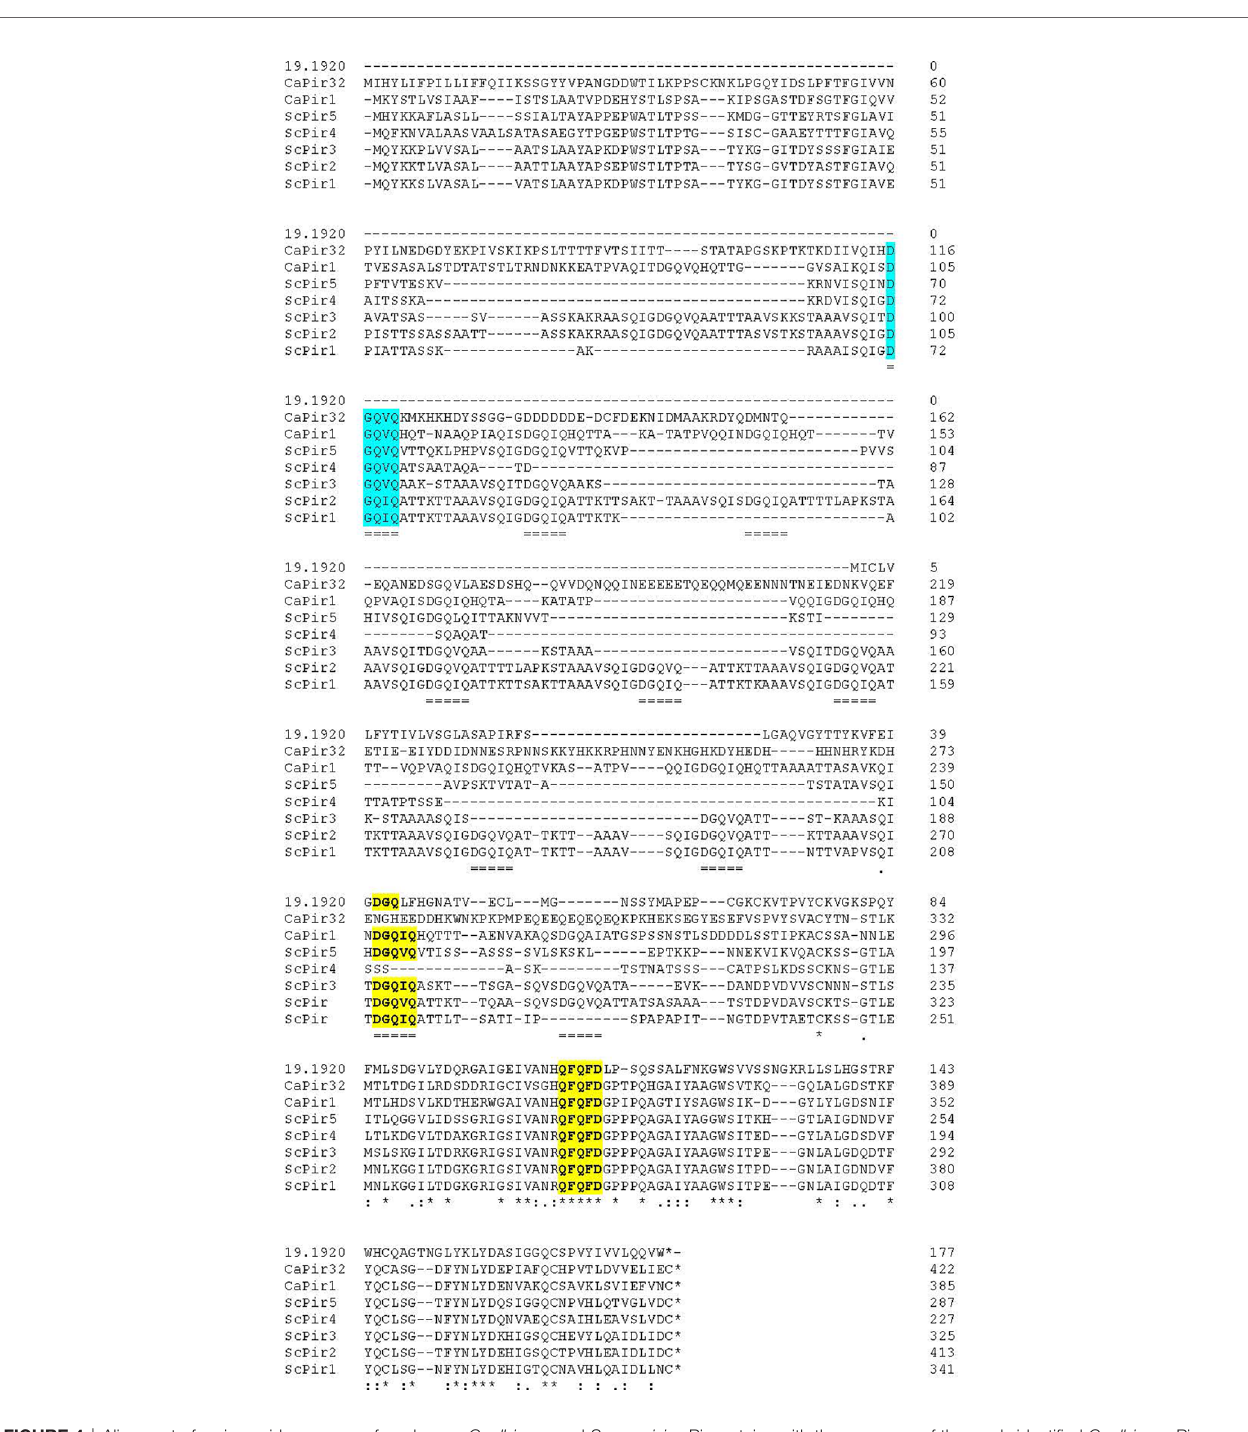
FIGURE 4 | Alignment of amino acid sequences from known C. albicans and S. cerevisiae Pir proteins with the sequence of the newly identi fi ed C. albicans Pir protein, orf19.1920. Sequence position within each protein was noted by the numbers on the right of the diagram. Alignment among DGQ[V/I]Q repeated sequences was marked with double underlining. Asterisks showed positions of identity among all sequences. The overall alignment showed that the conserved Pir repeat was most abundant in ScPir1, ScPir2, and CaPir1. Despite its highly divergent sequence, the conserved Pir repeat was also present in CaPir32 (blue highlight). The newly recognized orf19.1920 was considerably shorter than the other proteins and had one Pir consensus sequence, shortened to DGQ (yellow highlight). Conservation among all sequences was most evident toward the C-terminal end of the proteins leading to identi fi cation of additional shared sequence motifs such as QFQFD (yellow